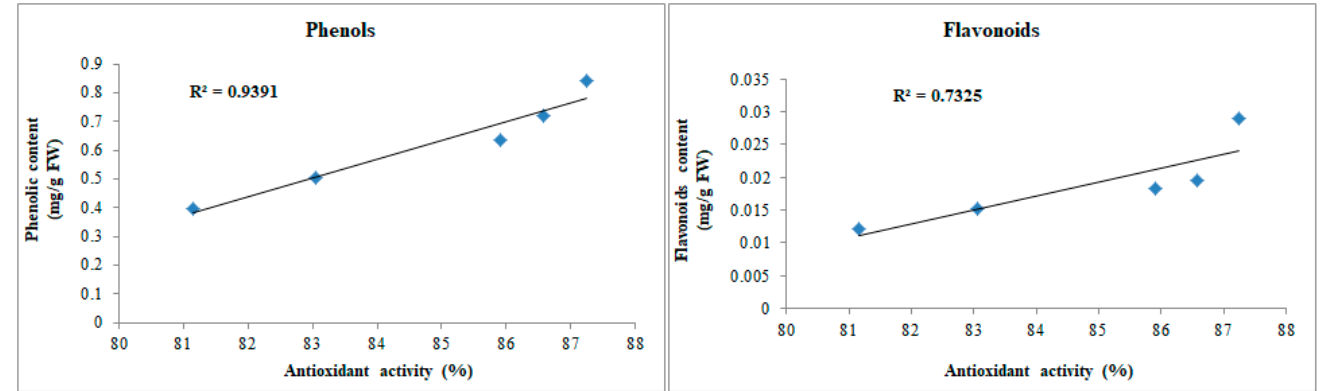
Figure 8. The correlation between the total phenolic and flavonoid contents and antioxidant activity of red radish roots affected by gamma-rays different dose levels.